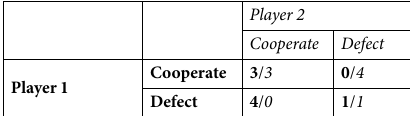
Table 1. In the Prisoner’s Dilemma Game, if the player (Player 1 or Player 2) cooperates and the partner defects, the defector receives four rewards (individual maximizing solution) and the cooperator receives none. If both cooperate, each player receives three rewards (group maximizing solution), while if both defect, each player receives one